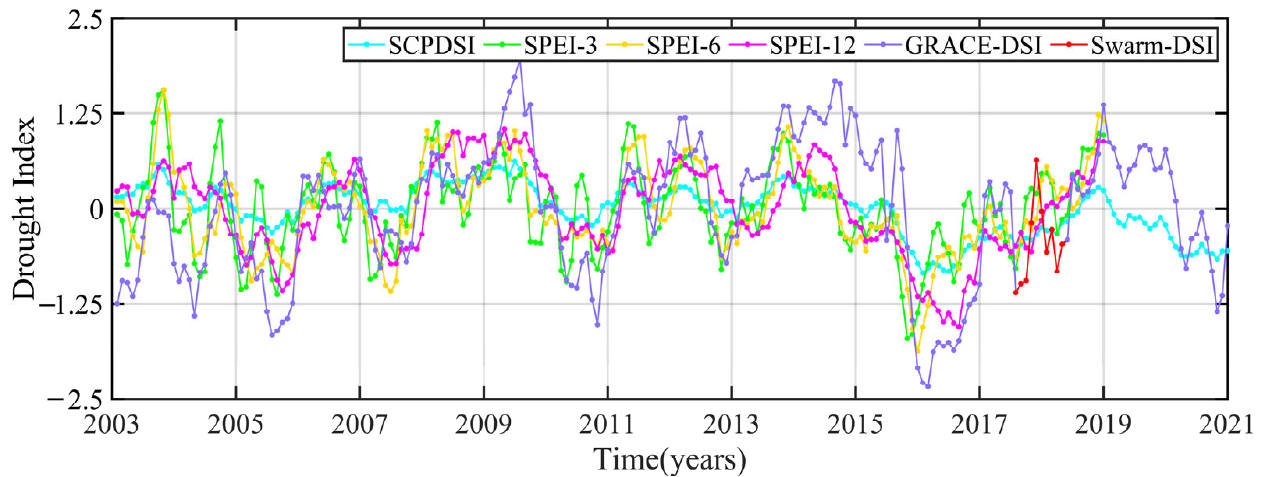
Figure 7. The spatial distribution of uncertainties of GRACE ‐ DSI and Swarm ‐ DSI in the ARB.